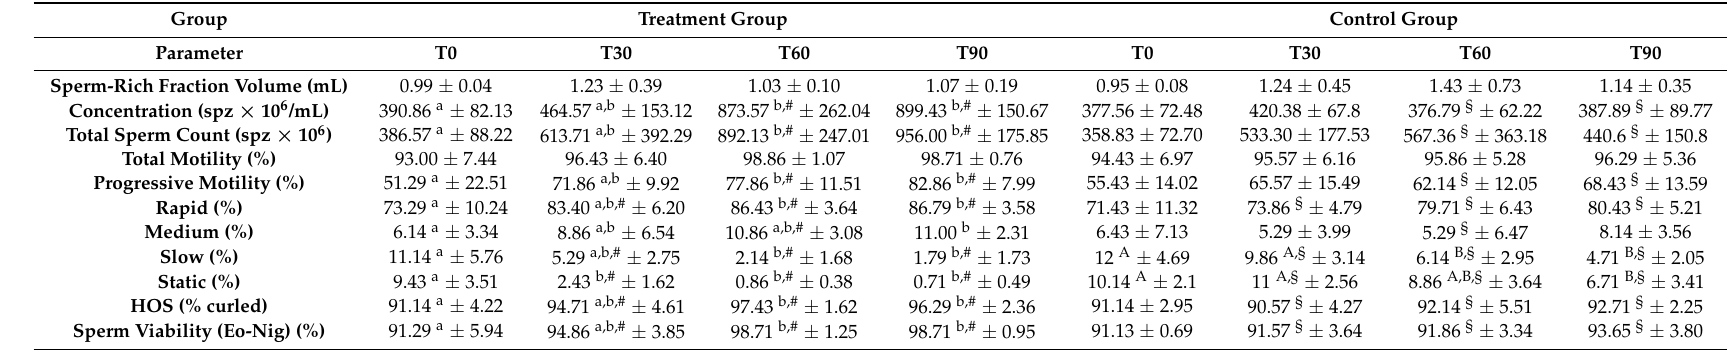
Table 2. Quantitative and qualitative parameters along time, reported as mean ± SD, obtained from all dogs from the same group (Treatment and Control group). Different superscripts denote statistically significant differences between columns within groups (lowercase (a and b) to underline statistical differences within T group, uppercase (A and B) within C group); different symbols denote statistically significant differences between times between groups (# in T group vs. § in C group). HOS: hypo-osmotic swelling